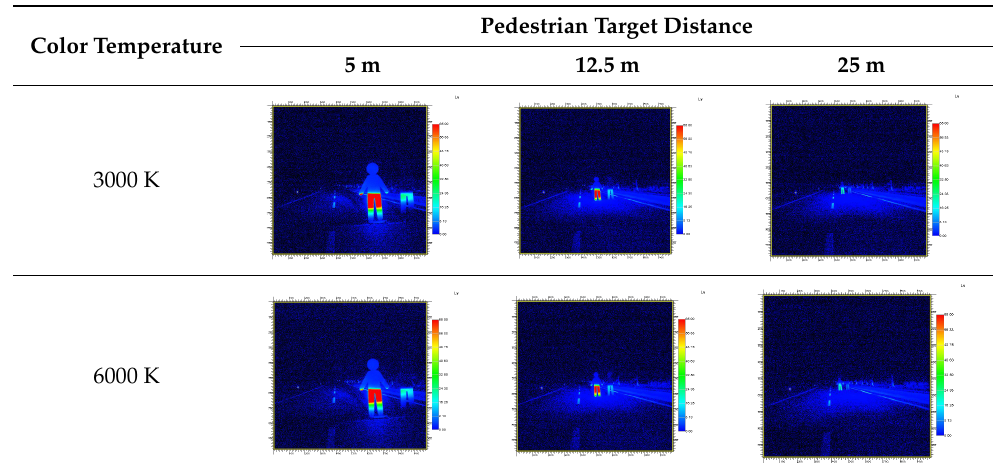
Table 4. Comparison of luminance by target distance and color temperature (clear condition).